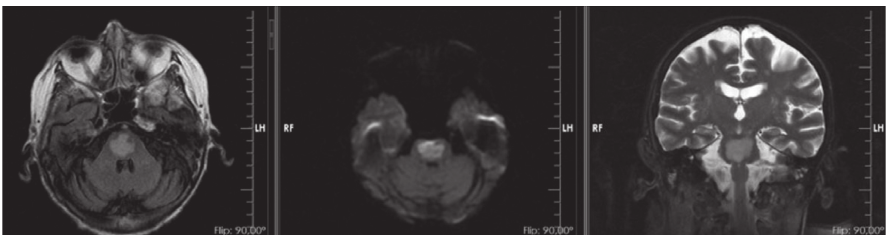
Figure 2: Cranial magnetic resonance showing findings in the pons suggestive of pontine myelinolysis (sequences: axial T2, diffusion, and coronal T2).